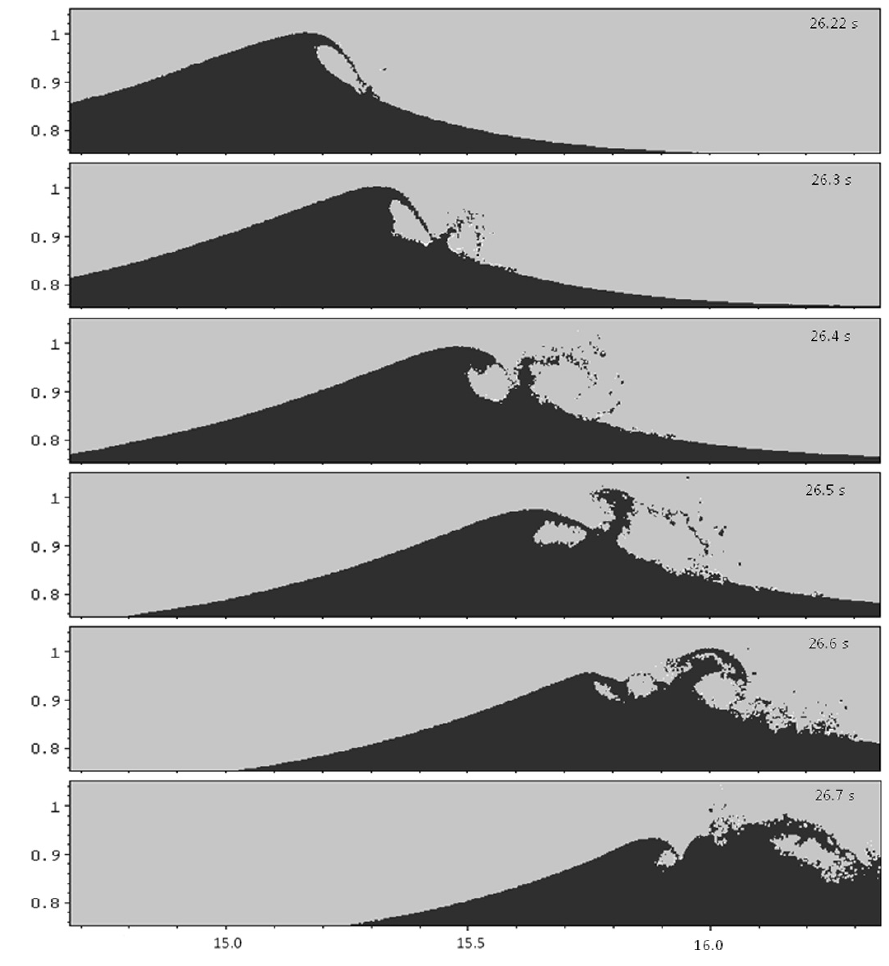
Fig. 9. Impingement of the plunging jet entraps an air pocket and creates a strong splash-up. Table 1. Computation time and speedup ratio versus number of processors. No. of proc Particles/1 proc Comp. time/1000 steps (min) Speedup Ideal